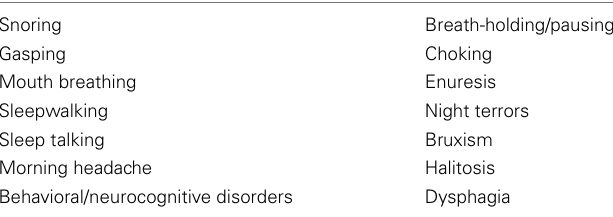
Table 1 | Symptoms of sleep disordered breathing